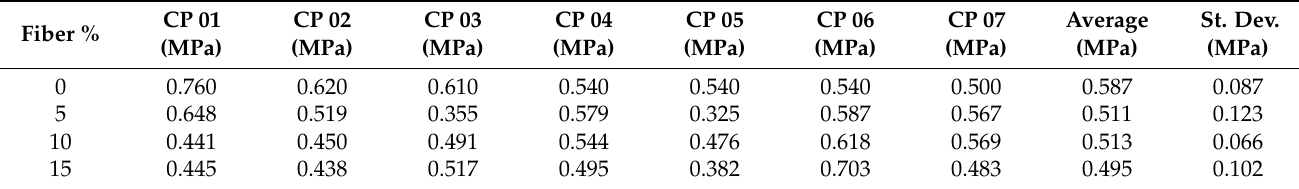
Table 3. Compressive strength.